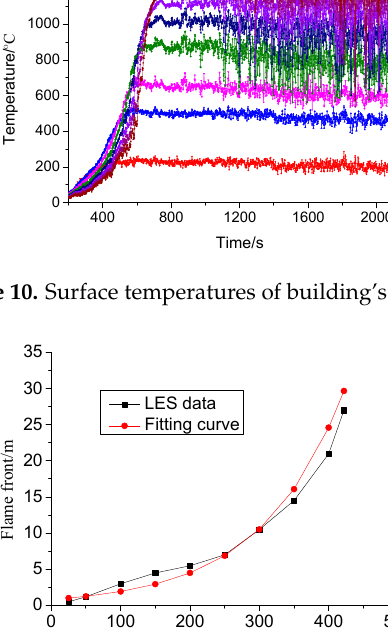
Figure 11. Flame spread in the vertical direction.